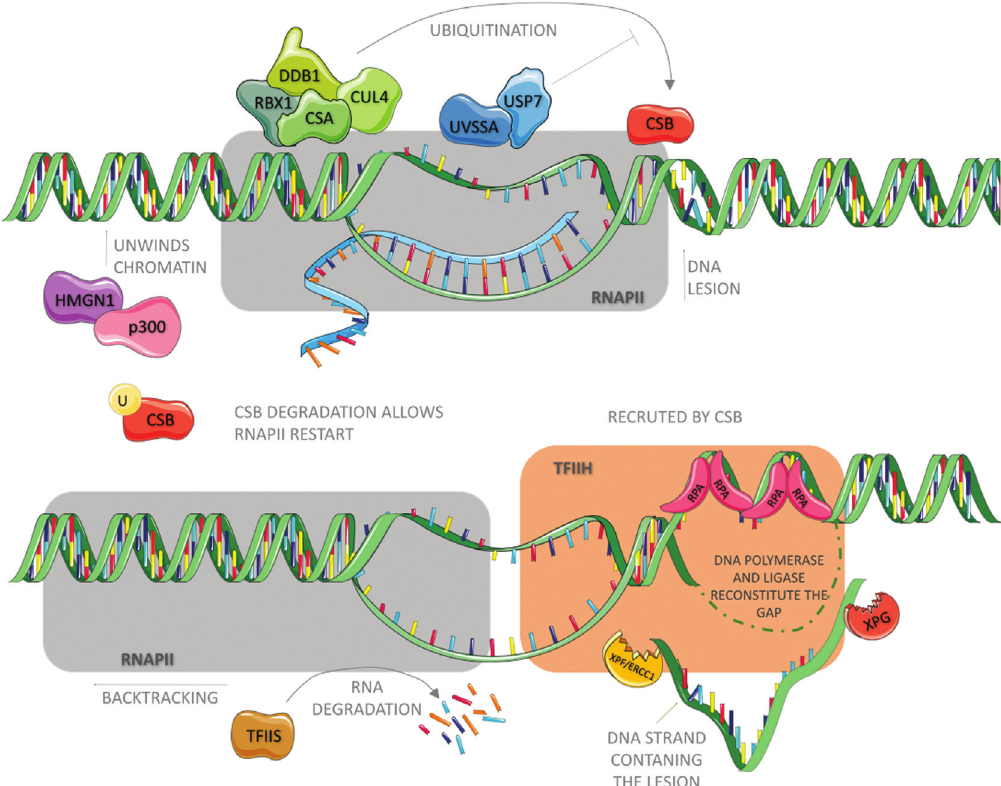
Figure 1 - Physical blockage of RNA polymerase II facilitates CSB binding to it. The following is responsible for recruiting p300, CSA and the other NER factors. CSA, together with CUL4, RBX1 and DDB1 are constantly ubiquitinating CSB, however UVSSA-USP7 complex are constantly removing ubiquitintagsfromit.CSAalsorecruitsHMGN1,whichtogetherwithp300unwindschromatinupstreamRNApolII,allowingittobacktrackandexpose the lesion site to NER factors. TFIIS stimulates RNA cleavage by RNApol II during this process. NER factors unwinds DNA around the lesion. While RPA protects ssDNA from degradation, XPG and XPF-ERCC1 endonucleases cleave the strand containing the lesion. DNA polymerase and ligase then fill up the gap. CSB degradation is necessary to RNA synthesis